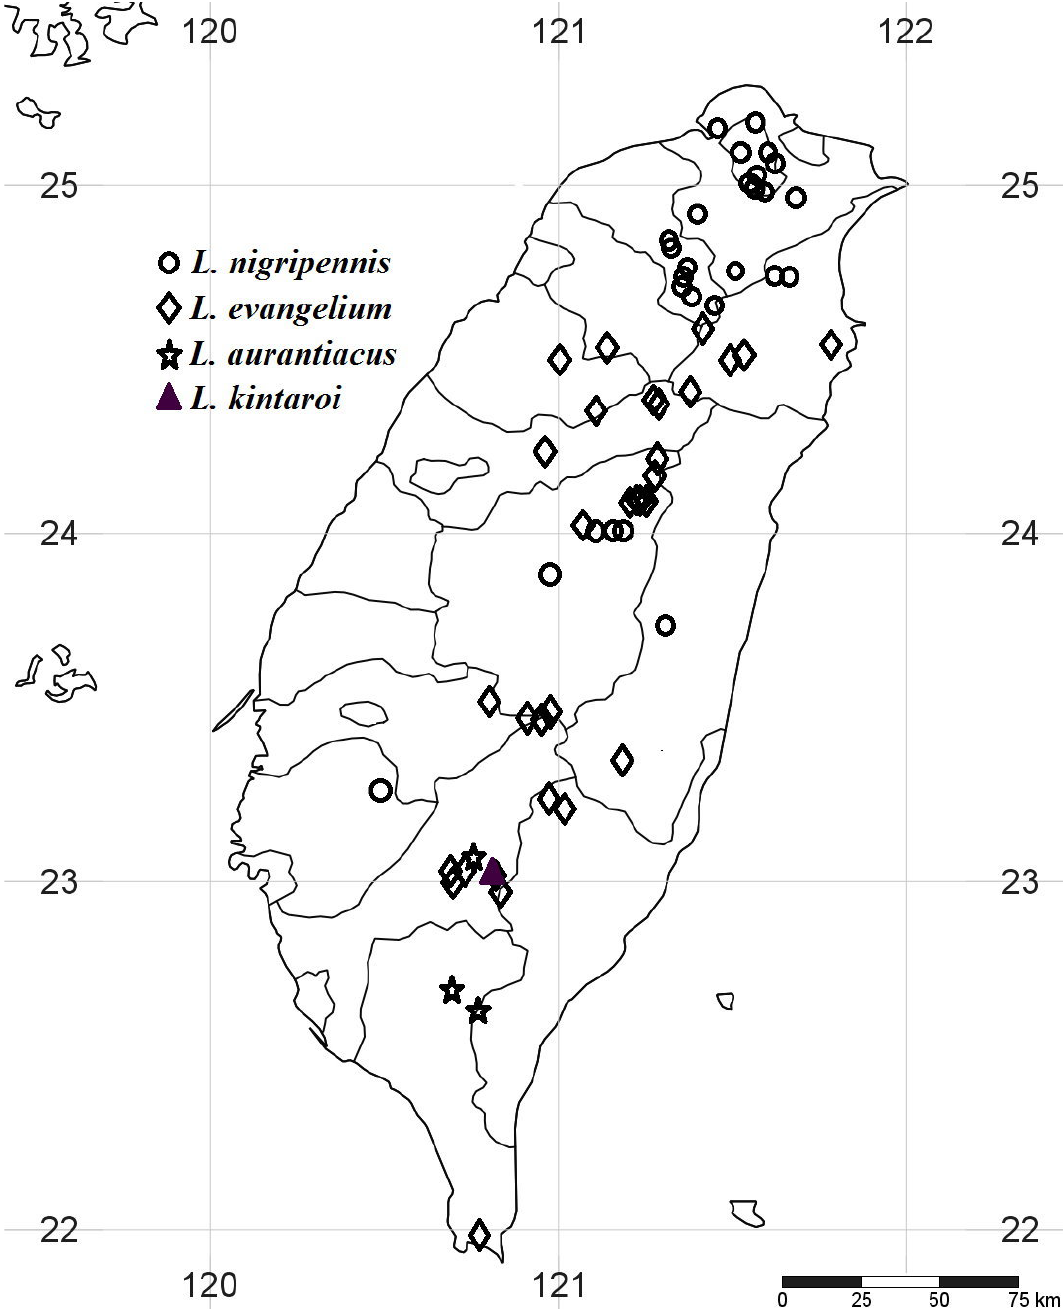
Fig. 8. Distribution map of L. nigripennis (Pic, 1938), L. evangelium Hsiao & Okushima sp. nov., L. aurantiacus Hsiao & Okushima sp. nov. and L. kintaroi Hsiao & Okushima sp. nov. from